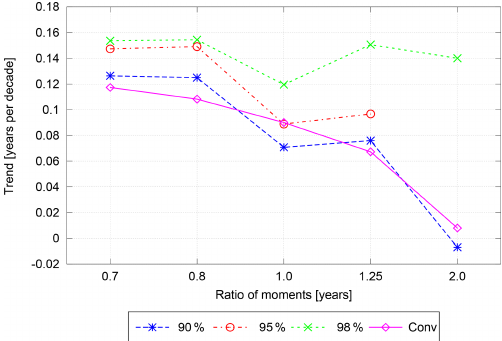
Figure 17. Trend in mean AoA derived from the observations for the fit method and the convolution method for the respective fraction of input and ratio of moments. Table 1. AoA trends recalculated from observations using the fit method and convolution method for different parameters. Within the presented decimals, the errors are